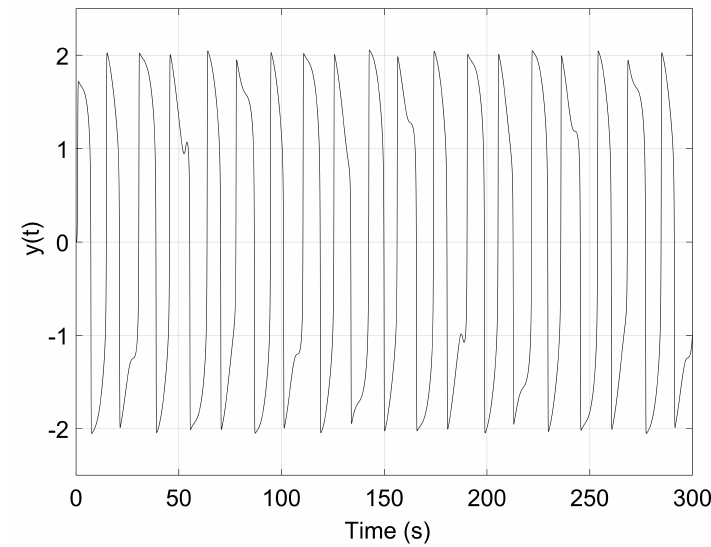
Figure 16. Solution obtained from NSM.